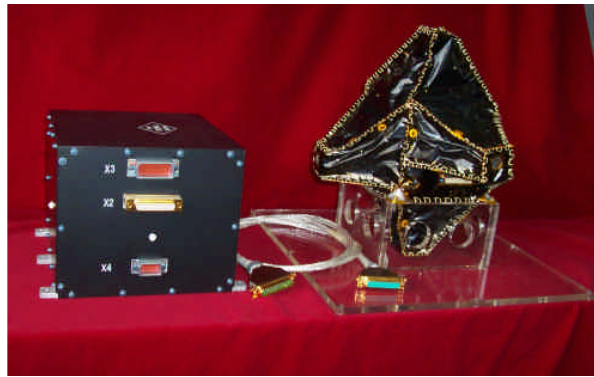
Fig. 1. The picture of the search coil and the electronic box of Fig. 1 The picture of the search coil and the electronic box of LFEW